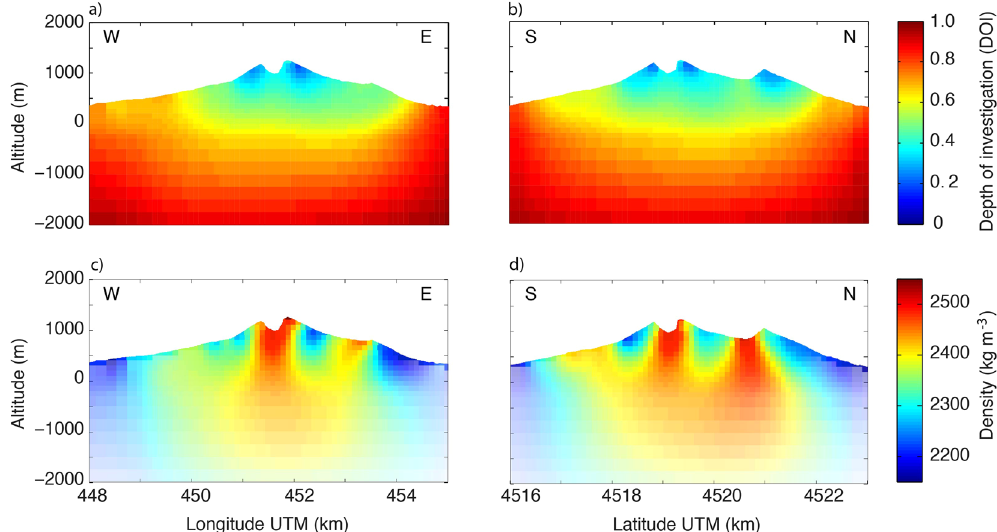
Figure 3. Depth of investigation (DOI) and vertical sections of the 3-D density model obtained with model regularization in terms of an isotropic roughness and damping constraints around 2200 kg m − 3 : ( a ) DOI for the west-east section at a latitude of 4519050 m and ( b ) the south-north section at a longitude of 451580 m; ( c , d ) corresponding density models. In ( c , d ), the DOI values are used to provide a qualitative (using transparency) assessment of how the model resolution decreases with depth. These sections also highlight how the inversion grid cells adapt to conform to the topography of the land surface at a resolution of 5 m. The locations of the two transects are highlighted in Fig. 1. The vertical sections were created using Matlab (version R2013b; www.